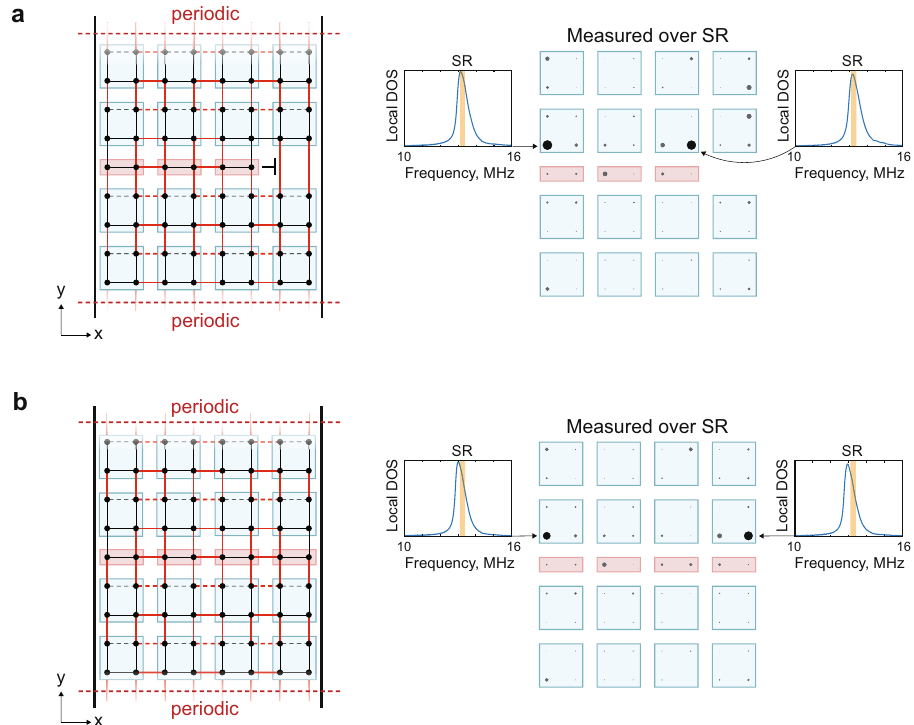
Fig. 3 Quadrupolar TCI partial dislocation experiments. a Topology of the measured quadrupolar TCI with an bulk-terminated partial dislocation and spatial map of the mode density at each site over the spectral range (SR) of 13.1 MHz – 13.4 MHz. The blue boxes represent complete quadrupolar unit cells, and the red boxes represent the partial dislocation. The red (black) lines denote strong (weak) coupling, and the dashed lines represent negative coupling. In the spatial map, each site is represented by a circle with radius proportional to the local mode density. The local DOS of the sites with the largest mode densities are shown in the inset and the SR is highlighted in orange. b Same as ( a ), but for a boundary-terminated partial dislocation. Complete local DOS measurements for all sites in ( a ) and ( b ) are presented in Supplementary Figures S8 and